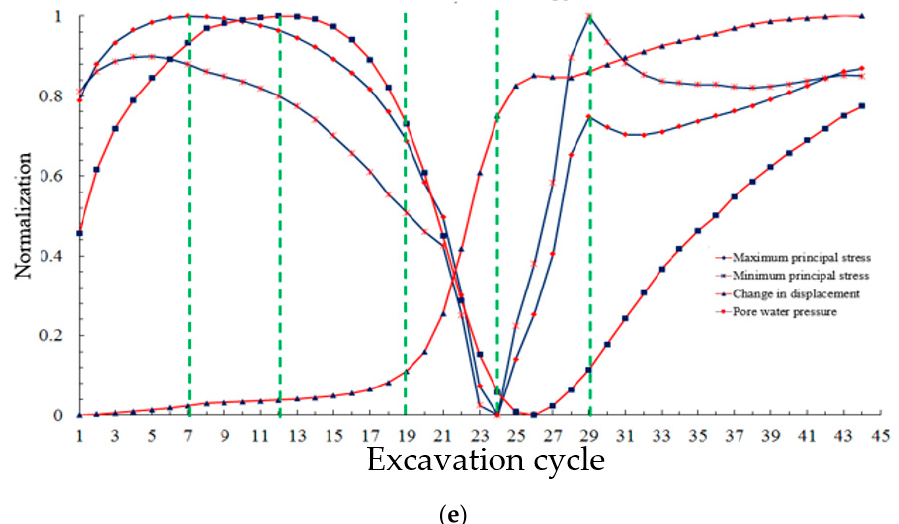
Figure 12. Variation curves of multivariate information at monitoring point R-1. ( a ) Time history of maximum principal stress; ( b ) Time history of minimum principal stress; ( c ) Time history of displacement in the x direction; ( d ) Time history of seepage pressure;( e ) Normalization curves of linear functions.